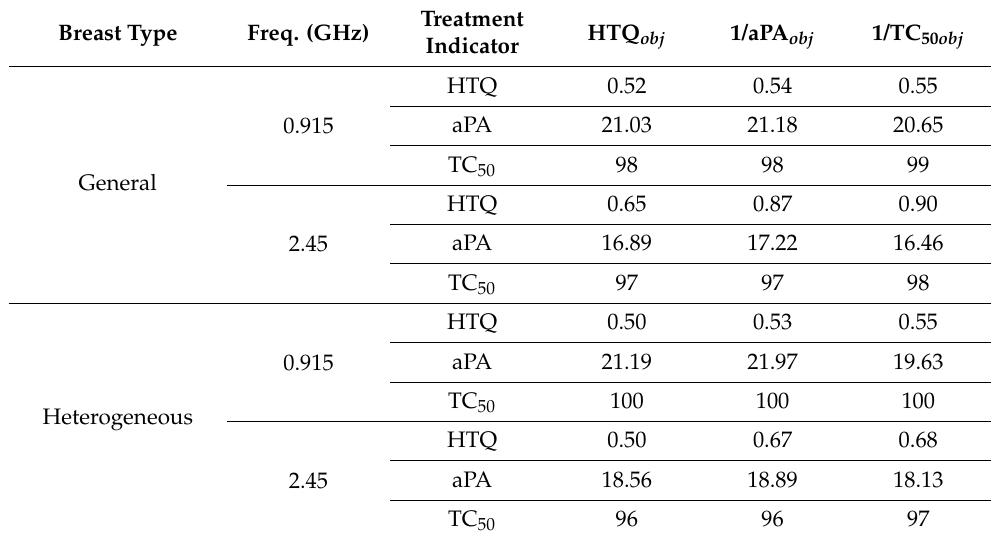
Table 6. Mean and standard deviation of treatment indicators of two breast models for each objective function used in